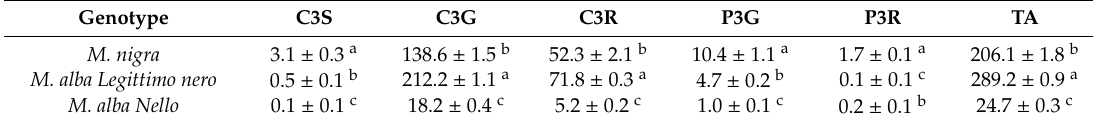
Amounts of cyanidin-3- O -sophoroside (C3S), cyanidin-3- O -glucoside (C3G), cyanidin-3- O -rutinoside (C3R), pelargonidin-3- O -glucoside (P3G) and pelargonidin-3- O -rutinoside (P3R) and Total anthocyanins (TA) in mulberry fruits. Values are expressed as C3G mg / 100 g FW and represent the results of three determinations ± SD. Means with di ff erent letters in the same column are significantly di ff erent from each other ( p < 0.05) according to the multicomponent Duncan’s test. Genotype